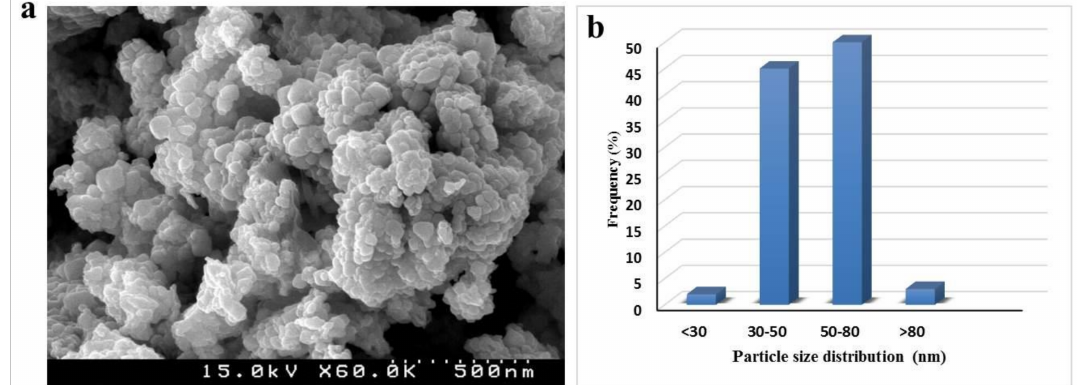
Figure 9. ( a ) SEM photograph and ( b ) size distribution graph of nano cadmium oxide (obtained by thermolysis of precursor 1